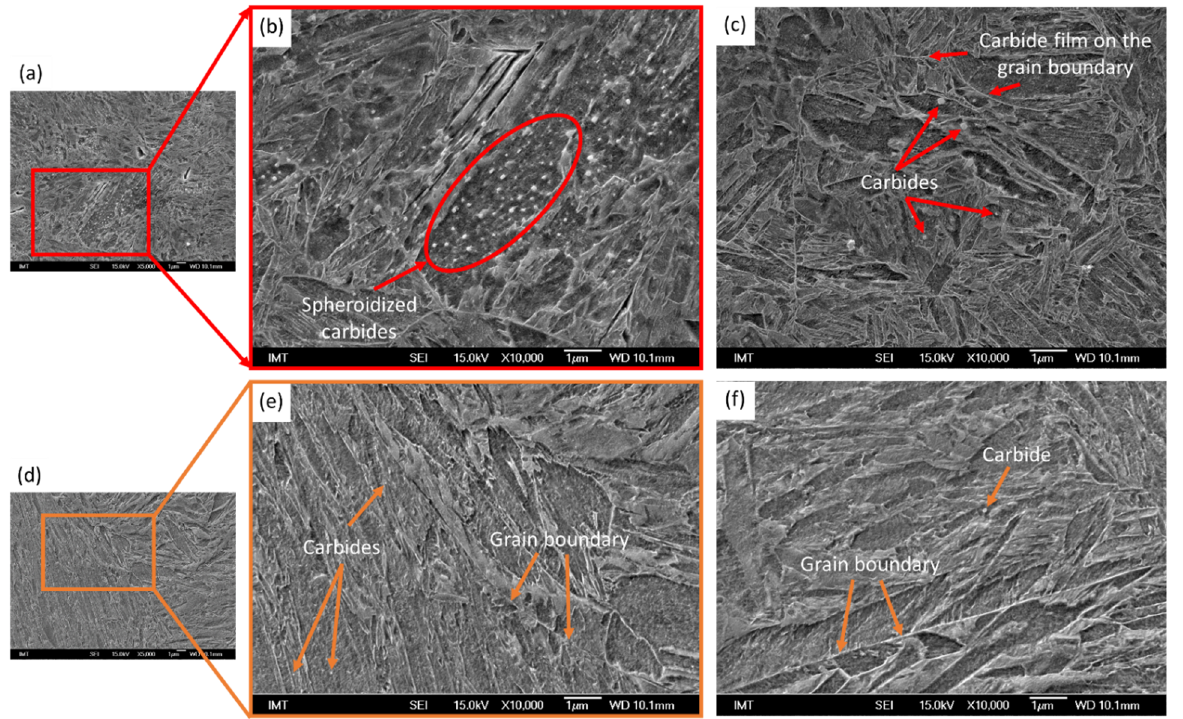
Figure 12. SEM images of quenched samples after 5 min at different austenitisation temperatures. ( a ) 800 ◦ C-5 min lower magnification, ( b ) 800 ◦ C-5 min, ( c ) 800 ◦ C-30 min, ( d ) 1040 ◦ C-5 min at lower magnification, ( e ) 1040 ◦ C-5 min, ( f ) 1040 ◦ C-30